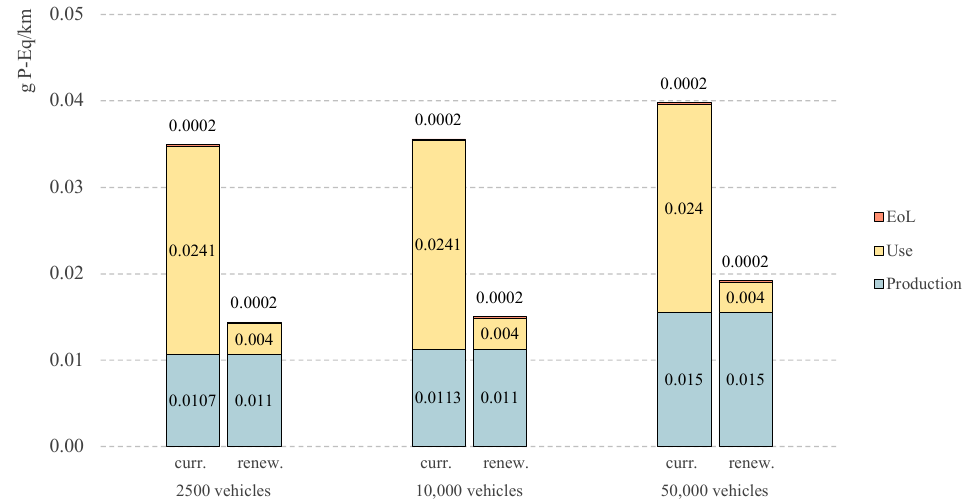
Figure 10. Lifetime eutrophication potential of e-moped fleets per kilometer; curr.—current German electricity mix of 2019, renew.—power grid mix resembling 100% renewable energies.